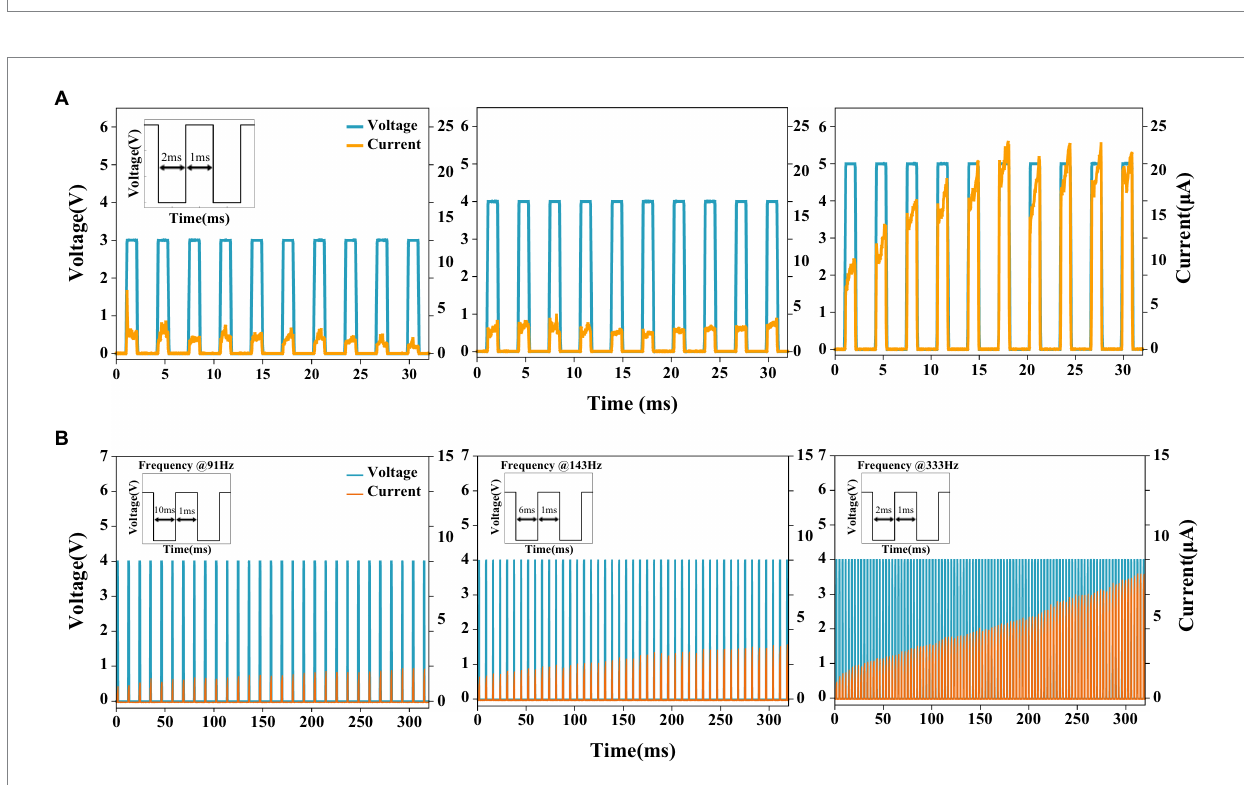
FIGURE 2 (A) Evolutions of the currents passing through the memristor upon receiving trains of pulses with different pulse amplitudes. (B) Evolutions of the currents passing through the memristor upon receiving trains of pulses with different pulse